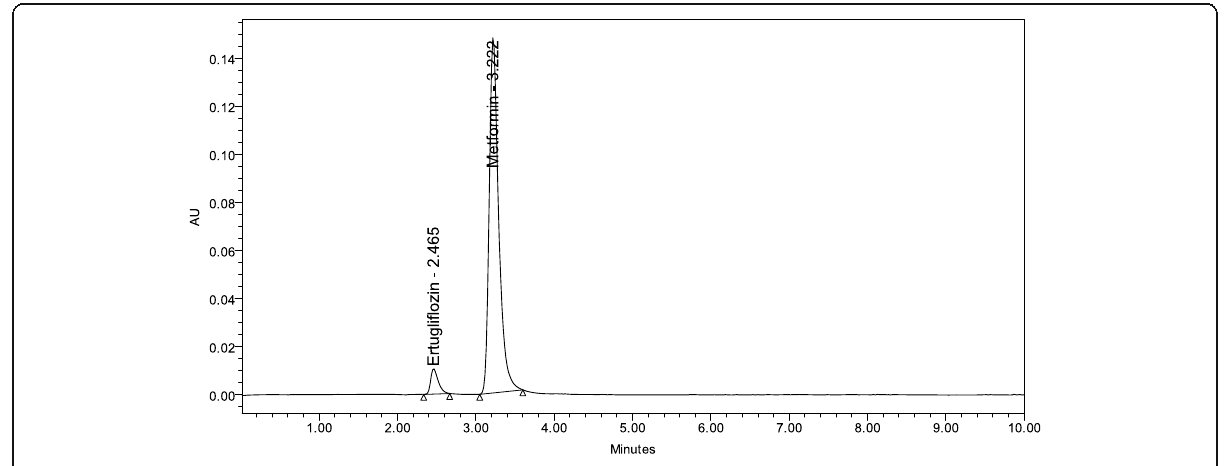
Fig. 9 Thermal degradation chromatogram of Ertugliflozin and